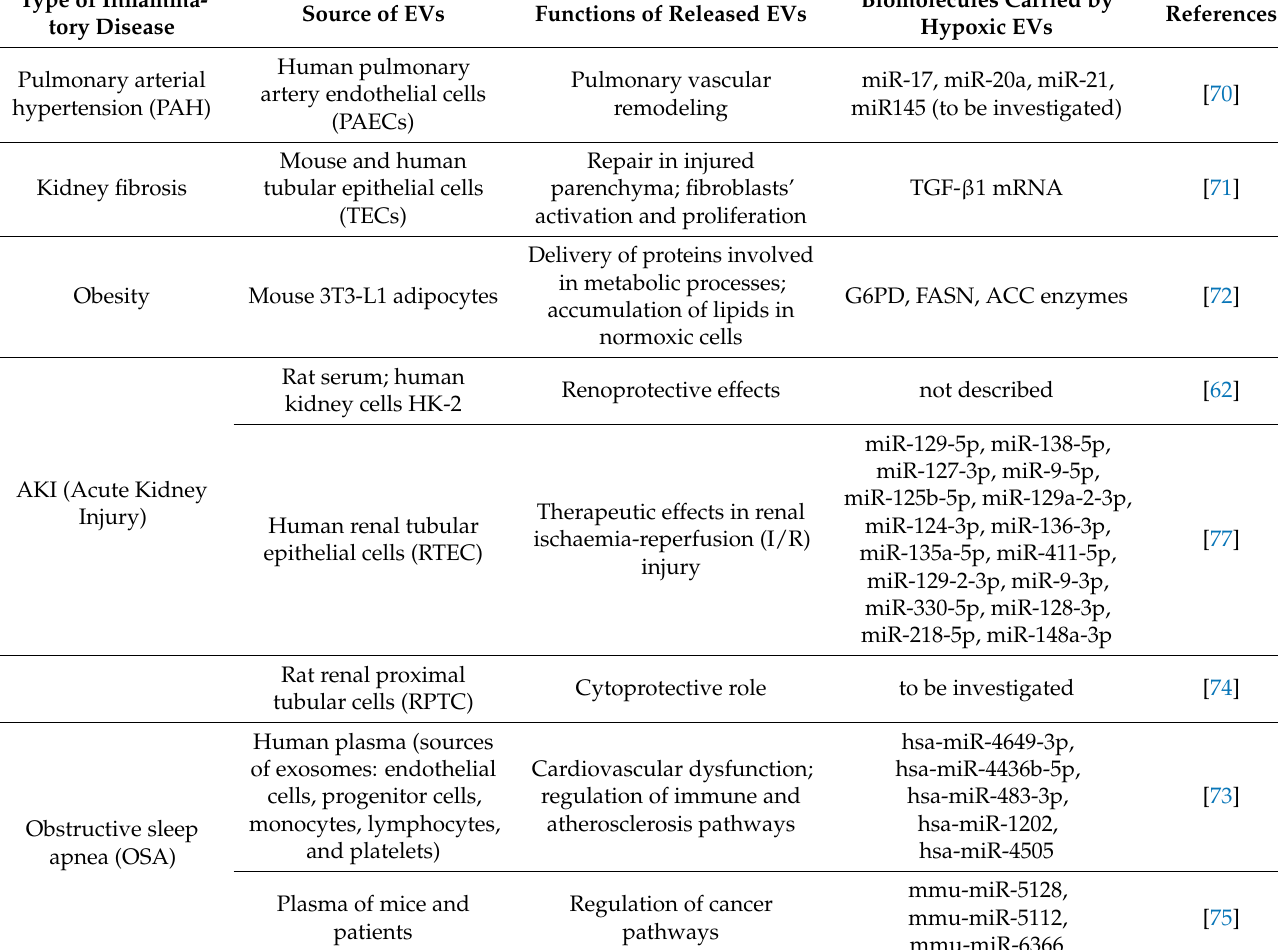
Table 2. Effects of hypoxia on EVs in inflammatory